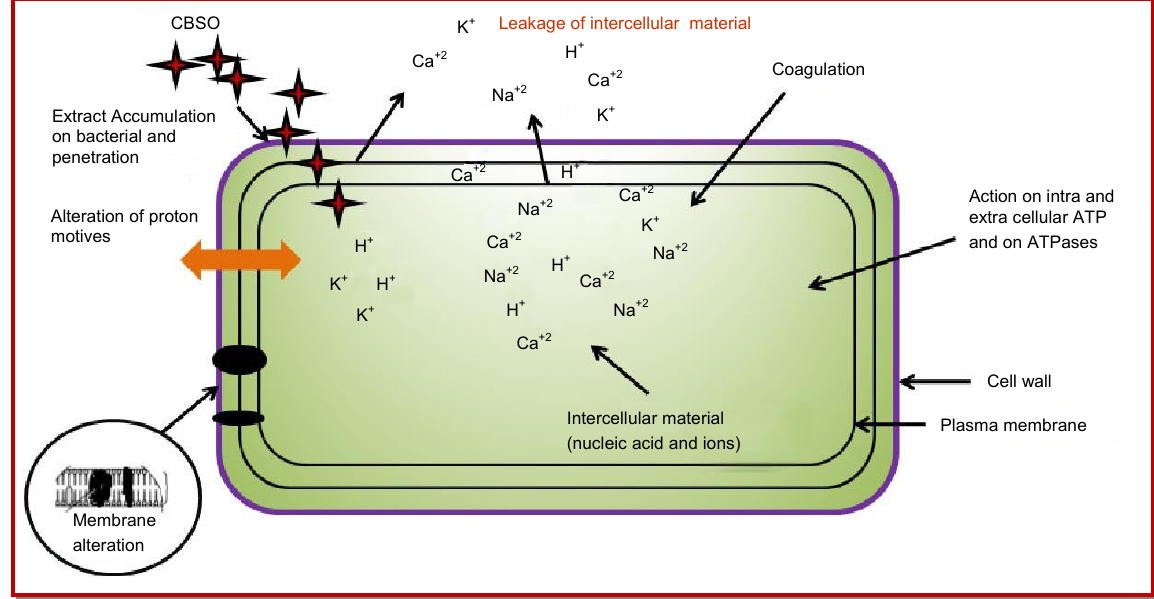
Figure 4: Proposed mechanism of the antibacterial mode of action of Caesalpinia bonducella seed oil against food-borne pathogen- ic bacteria